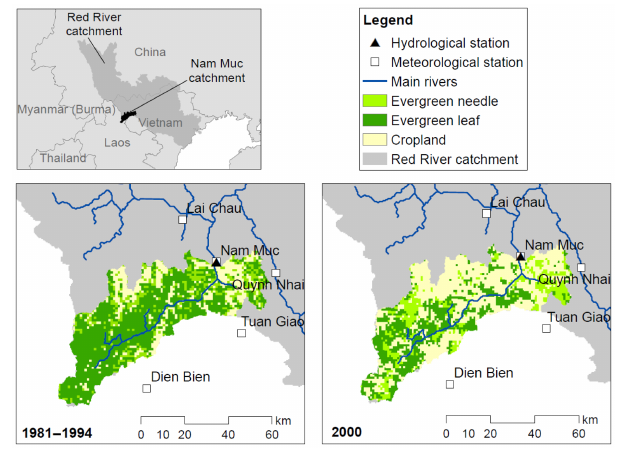
Figure 1. Study catchment showing gauges and changes in land cover over